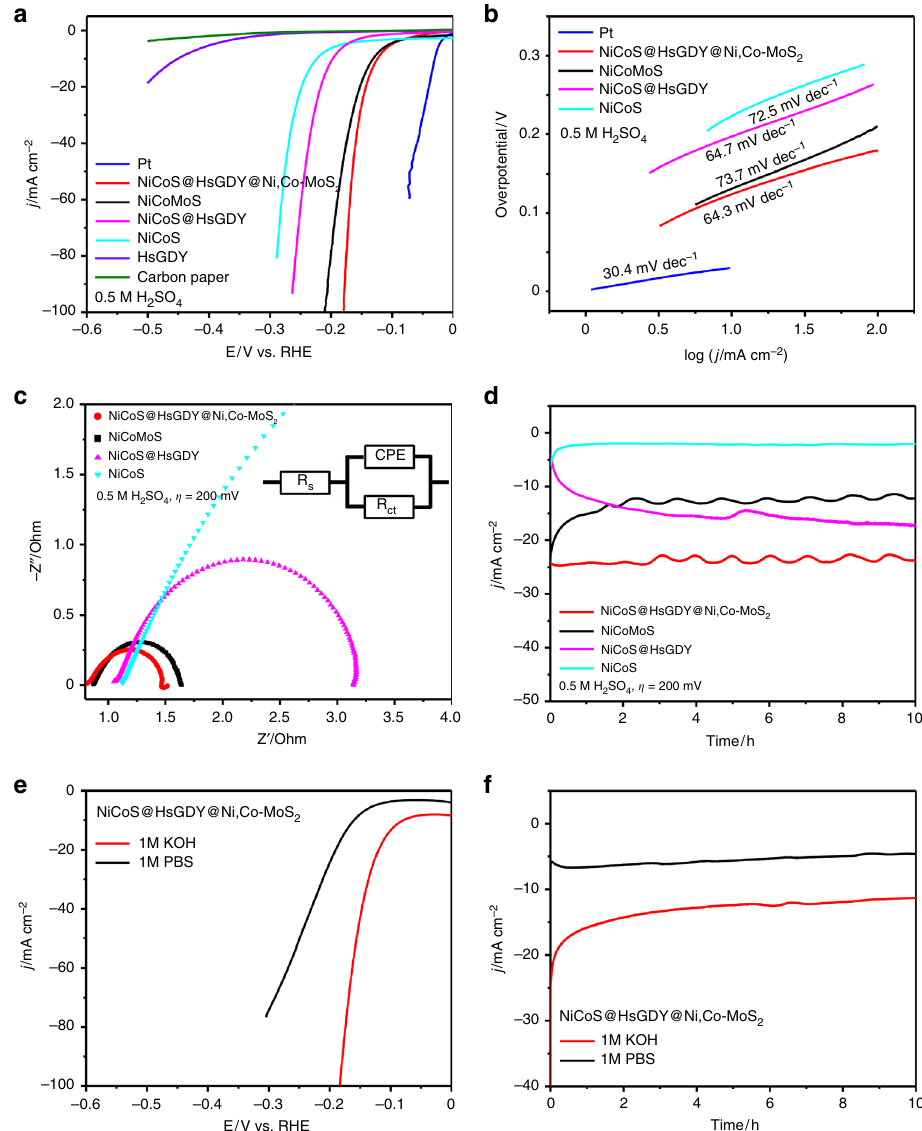
Fig. 7 Electrochemical evaluation of hydrogen evolution reaction performance. a Hydrogen evolution reaction (HER) polarization curves with iR - compensations, b Tafel plots, c Nyquist plots derived from electrochemical impedance spectroscopy (EIS), with an equivalent circuit (CPE constant phase element, R s equivalent series resistance, R ct charge transfer resistance), d time-dependent current density curves without iR -compensations of Ni 3 S 2 / Co 9 S 8 (NiCoS)@hydrogen-substituted graphdiyne (HsGDY)@Ni-,Co-co-doped MoS 2 (Ni,Co-MoS 2 ), mixed Co 9 S 8 , Ni 3 S 2 , and Ni,Co-MoS 2 (NiCoMoS), NiCoS@HsGDY, NiCoS, HsGDY, Pt sheet and Carbon paper in 0.5 M H 2 SO 4 (pH = 0.5). e HER polarization curves with iR -compensations and f time- dependent current density curves without iR -compensations of NiCoS@HsGDY@Ni,Co-MoS 2 in 1 M KOH (pH = 14.1) and 1 M phosphate buffer solution (PBS) (pH = 7.1),